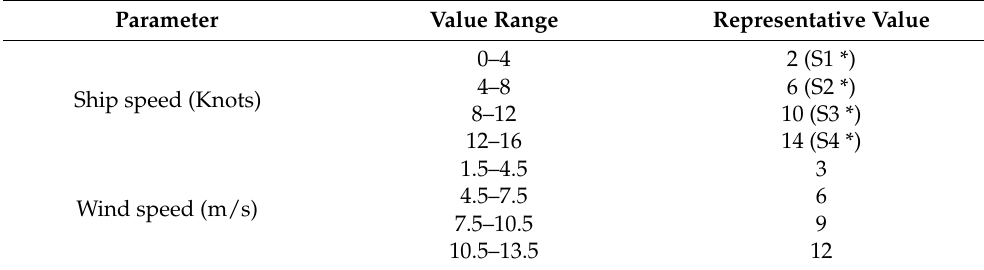
Table 1. Representative values of wind speed and ship speed.